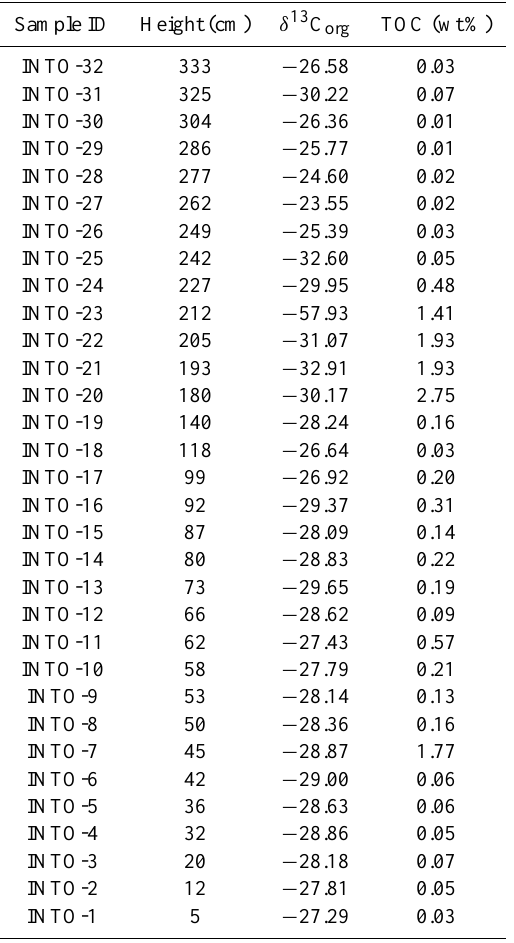
Table 1. Isotope and total organic carbon (TOC) results from the Katsuyama section, Inuyama,